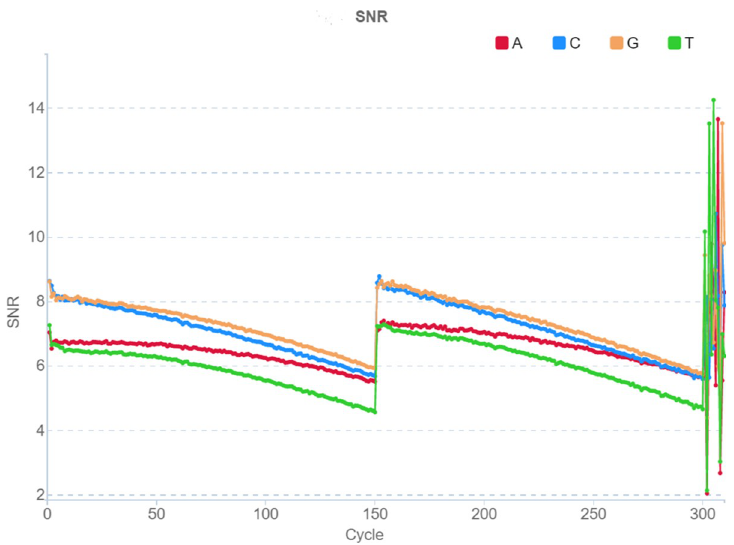
Fig 2. Example of a single lane SNR for a PE150 run on MGISEQ-2000. Sequencing cycles corresponding to the sequence number of the nucleotide in the reads are shown horizontally: 1:150 –forward read, 151:300 –reverse read, 301:310 –barcode sequence, SNR indicator is shown vertically. The indicator for each of the nucleotide types is marked by its own color (the colors are shown in the figure).